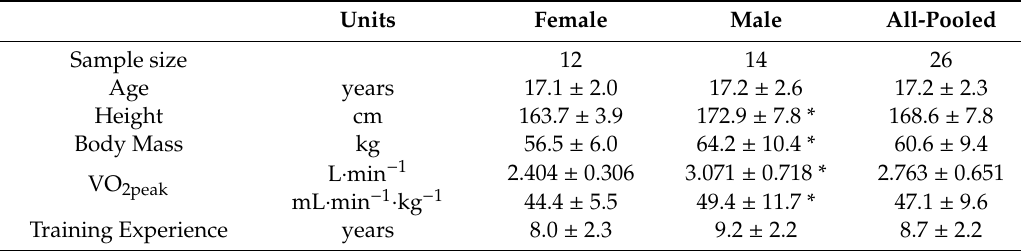
Table 1. Participants’